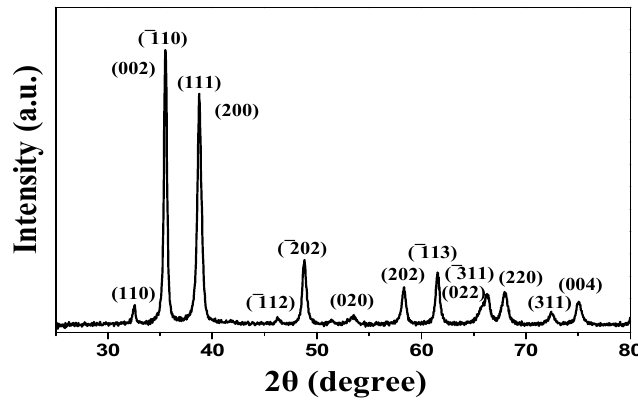
Figure 2. XRD pa tt ern of CuO NPs. Figure 2. XRD pattern of CuO